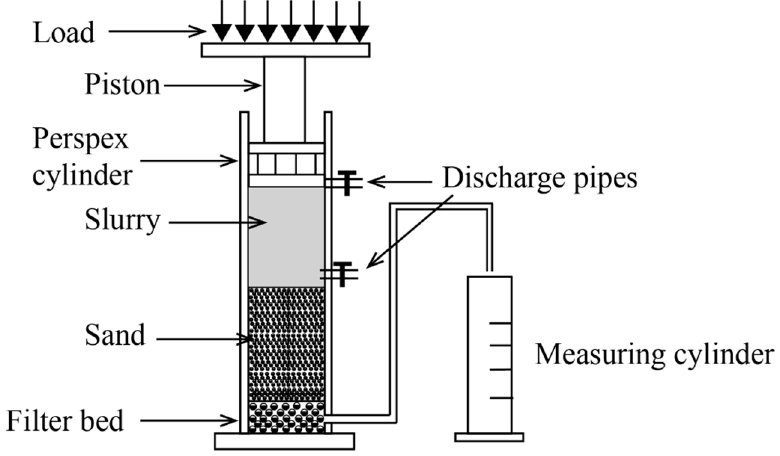
Figure 2. Schematic diagram of a slurry infiltration column test (adapted from [7]).